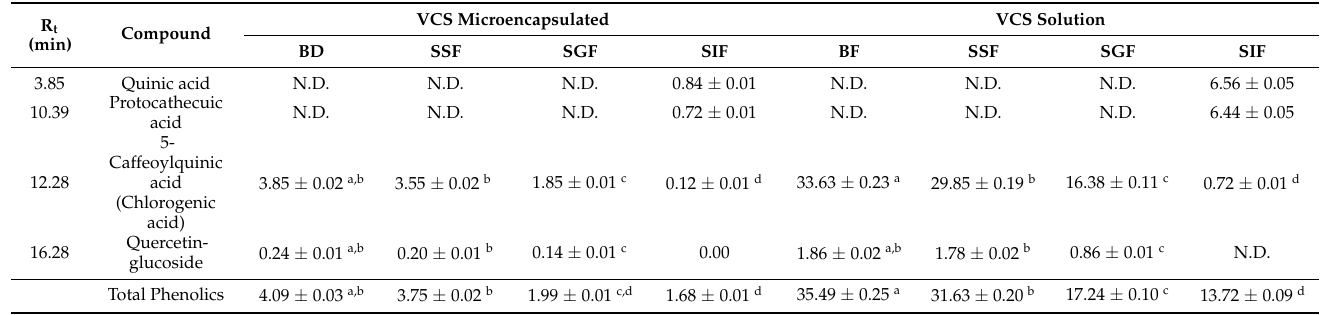
Table 4. Effect of salivary, gastric and intestinal in vitro digestion model on the phenolic content of VCS